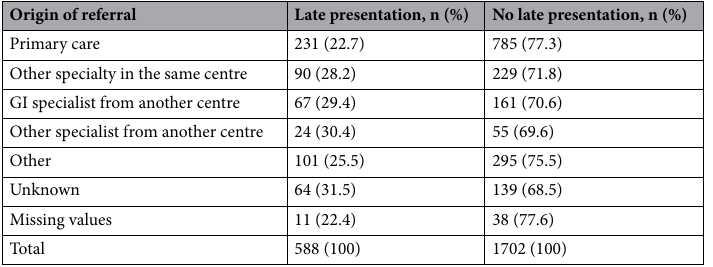
Table 4. Referral origin of LP patients, compared to those who did not present late (Spain, 2018/2019). LP late presentation.